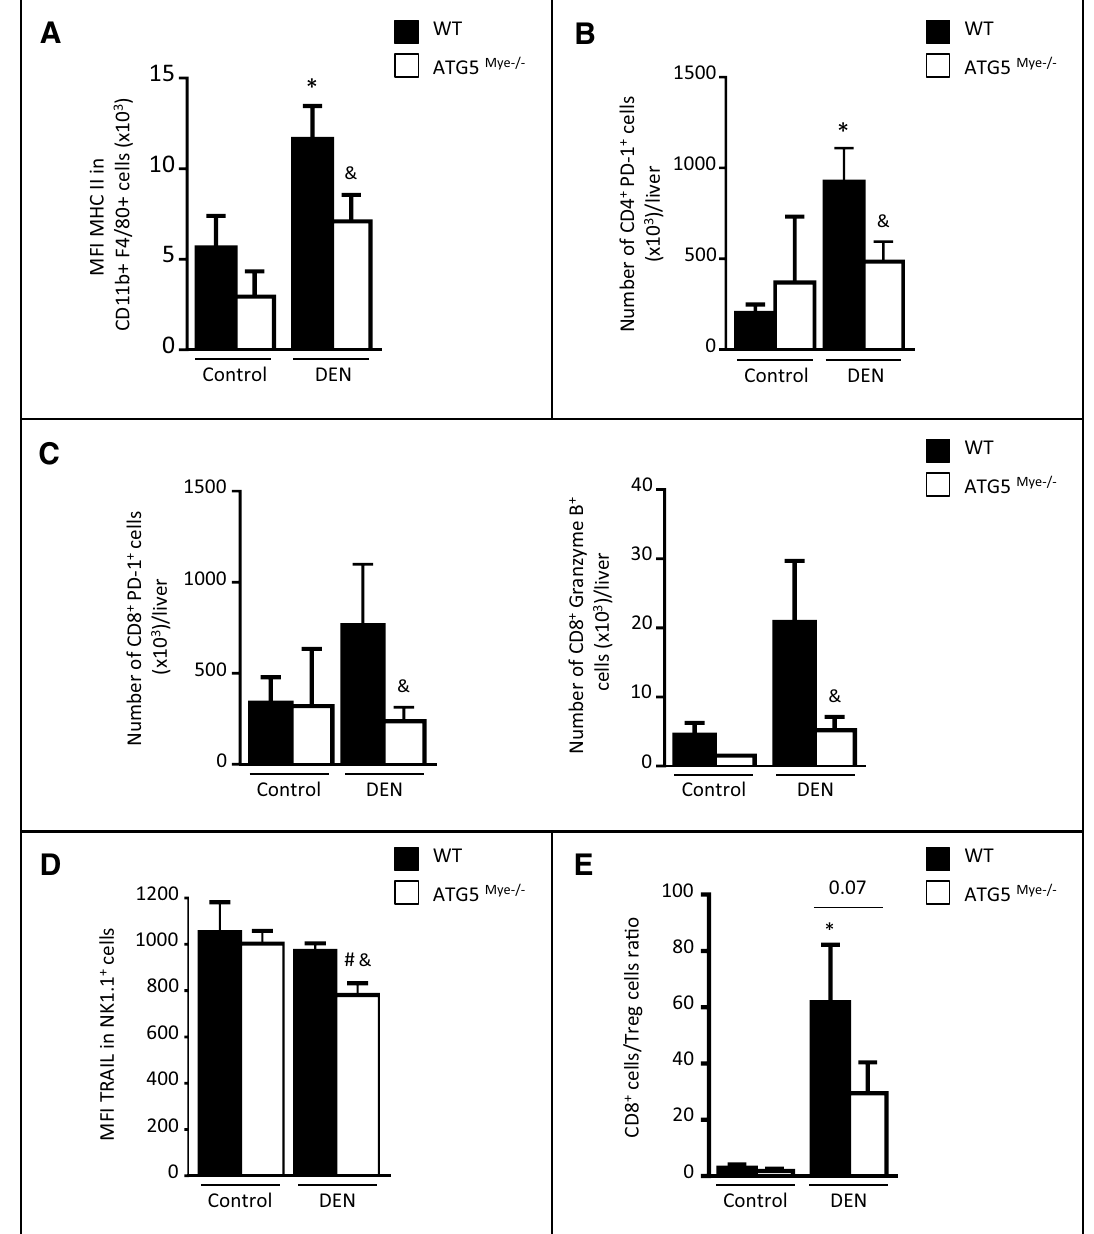
Figure 3. ATG5 Mye−/− mice display alteration in the hepatic immune cell activation. ( A ) MFI of MHC II in CD11b + F4/80 + cells in WT or ATG5 Mye−/− mice 10 months after DEN or saline solution administration. ( B ) Number of CD4 + PD1 + T cells per liver in WT or ATG5 Mye−/− mice 10 months after DEN or saline solution administration. ( C ) Number of CD8 + PD1 + T cells and CD8 + Granzyme B + cells per liver in WT or ATG5 Mye−/− mice 10 months after DEN or saline solution administration. ( D ) MFI of TRAIL in NK1.1 + cells in WT or ATG5 Mye−/− mice 10 months after DEN or saline solution administration. ( E ) CD8 + cells/Treg cells ratio in WT or ATG5 Mye−/− mice 10 months after DEN or saline solution administration. Data are shown as mean ± SEM. *, p < 0.05 for WT Control vs WT DEN, # for ATG5 Mye−/− Control vs ATG5 Mye−/− DEN and &, p < 0.05 for WT vs ATG5 Mye−/− . n = 3–6 for WT mice Control; n = 4 for ATG5 Mye−/− mice Control; n = 6–10 for WT mice DEN; n = 6–13 for ATG5 Mye−/− mice